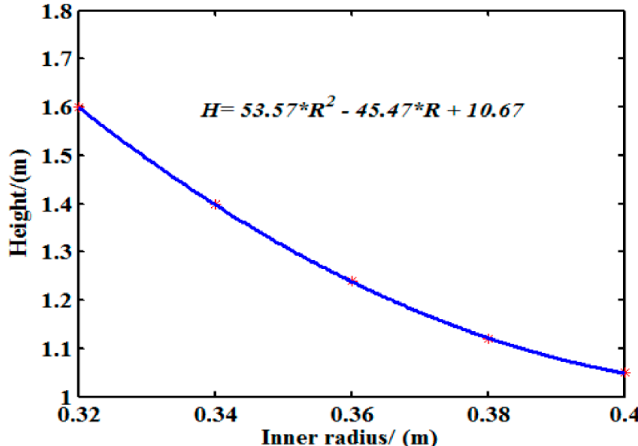
Figure 12. The fitted curve between the inner radius and encapsulation height.